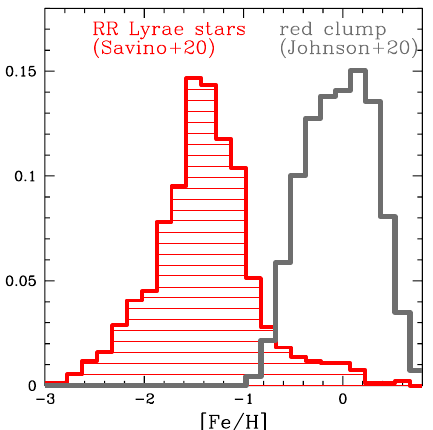
Figure 1. The normalized metallicity distribution for ∼ 900 BRAVA-RR inner Galaxy RRLs (shaded histogram) in comparison with the distribution of ∼ 2 million inner Galaxy red giants (solid thick line) selected from the Bulge DECam Bulge Survey catalog of Johnson et al. (2020) [25]. The distribution of RRLs is considerably more metal-poor than the dominant bulge